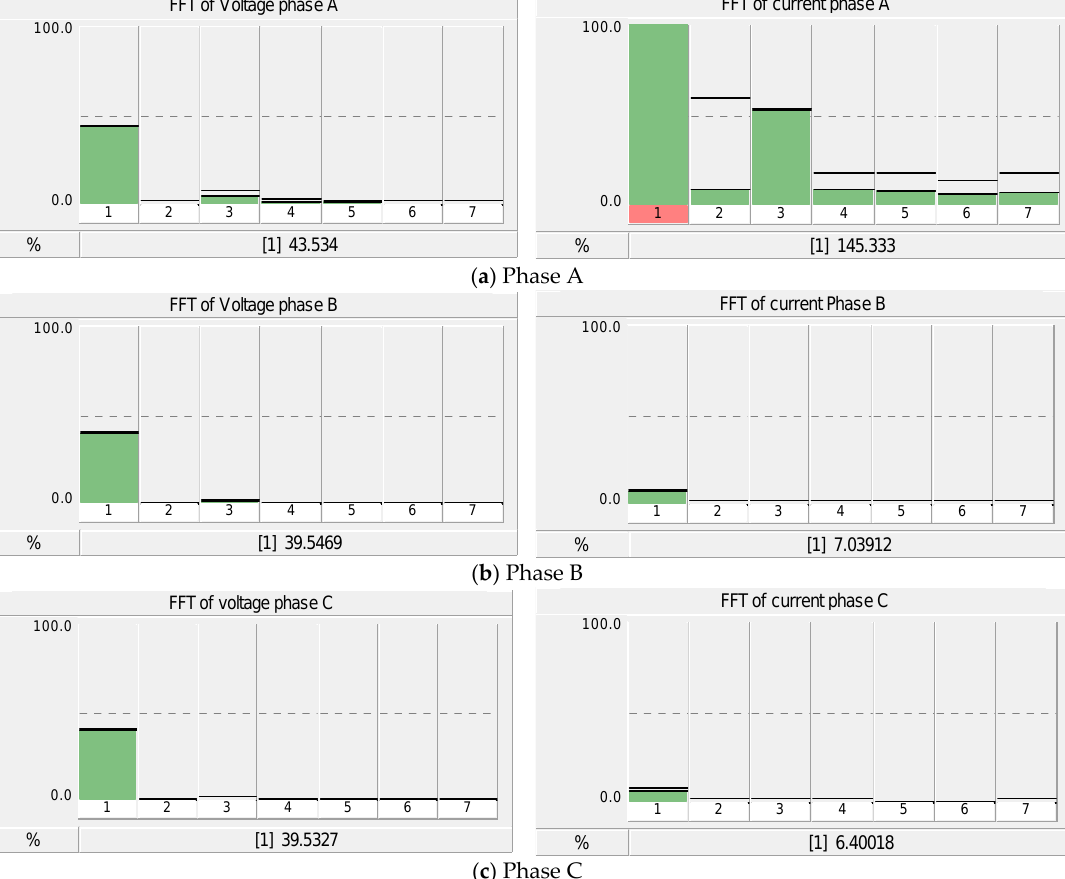
Figure 24. The frequency spectrum of the phase voltage and current at the LV side (0.4 kV) transformer 500 kVA when the BRKA close circuit is at 0.6 s.